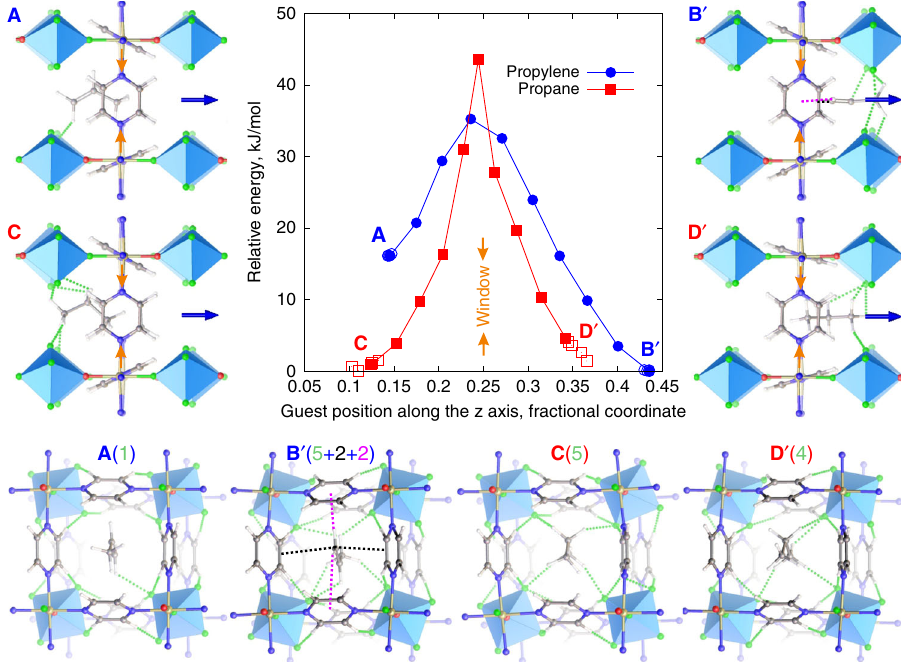
Fig. 2 DFT calculations of guests near the window. The local adsorption minima (empty symbols) for propylene ( fi ve overlapping blue circles for each site) and propane ( fi ve overlapping red squares for each site) near the window (marked by the orange arrows in the snapshots and in the graph at z = 0.25; the anions are located at z = 0 and z = 0.5) and the representative minimum energy path (MEP) pro fi le calculated using the climbing image Nudged Elastic Band (NEB) DFT method 14 ( fi lled symbols) for propylene (blue circles) and propane (red squares) in NbOFFIVE -1-Ni. The energy relative to the lowest energy con fi guration is shown as a function of the position of the central carbon on the C 3 H 6 or C 3 H 8 guest molecule. The snapshots show the stable con fi gurations for propylene ( A and B ′ ) and propane ( C and D ′ ) on each side of the window. The guests rotate by 90° as they pass through the window owing to the shape of the channel. The pyrazine rotation as a function of guest position for both guests is shown in Supplementary Fig. 6. The green dotted lines show the C – H···F contacts shorter than 2.67 Å, the sum of van der Waals radii for H and F, with their total number indicated in brackets. Face-to-face (black dotted lines showing two carbon-to-double-bond distances of 3.18 Å each) and edge-to-face (magenta dotted line showing hydrogen-to-centroid distances of 2.75Å and 3.35 Å) π – π interactions are shown for propylene in B ′